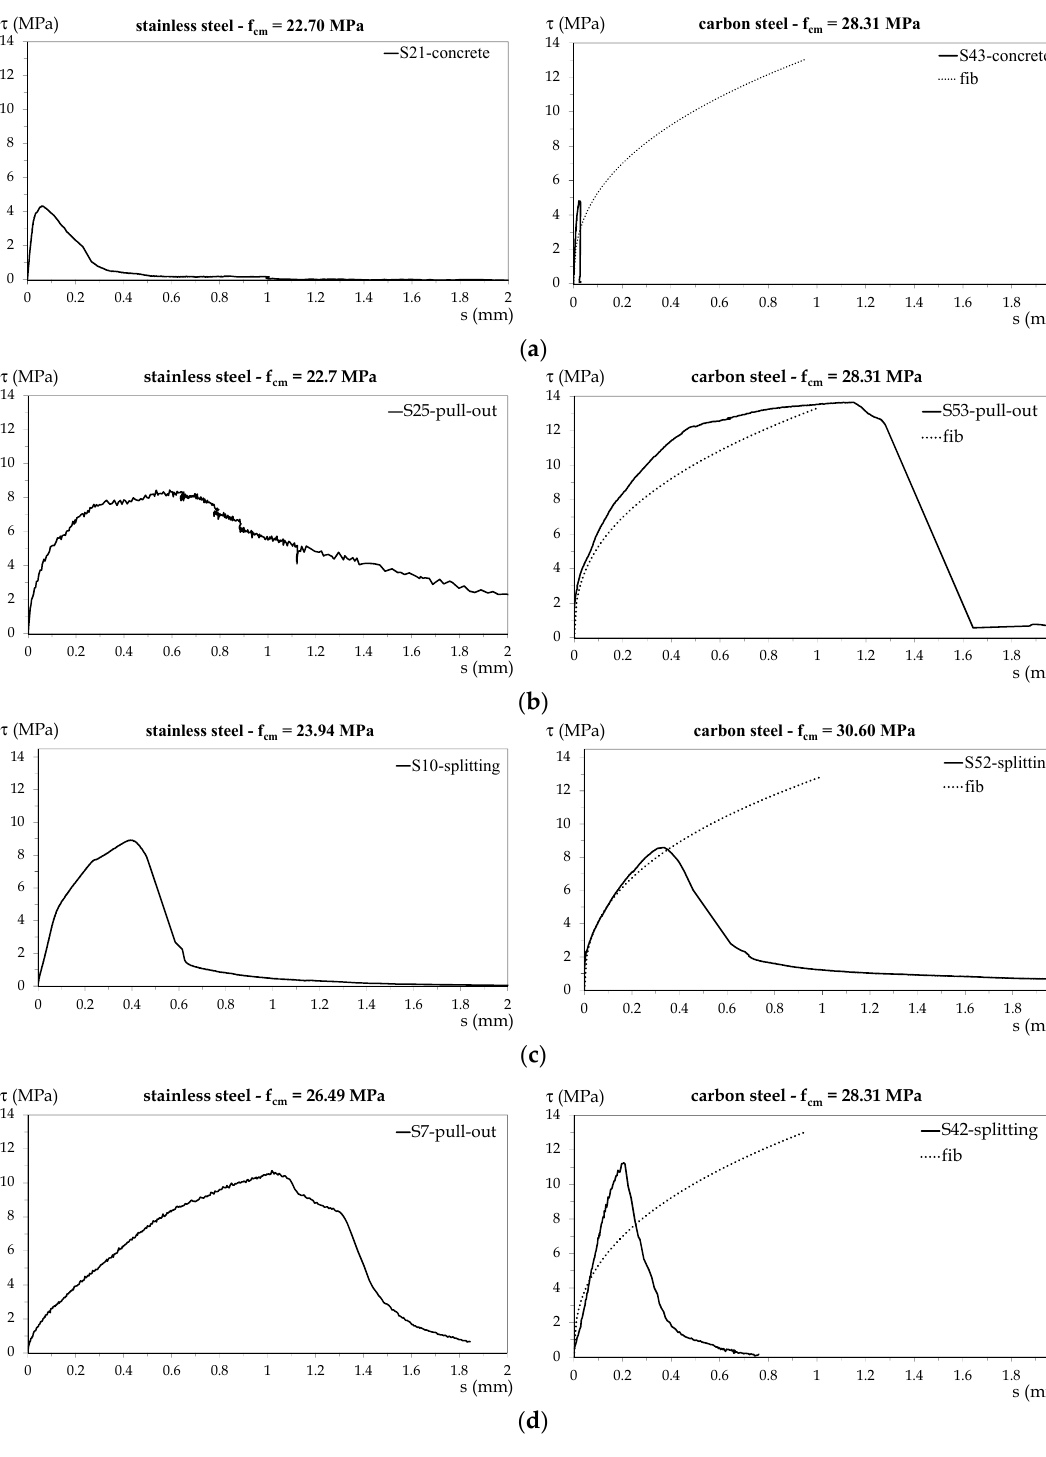
Figure 10. Bond stress–slip diagrams for specimens subjected to different failure types: ( a ) tensile concrete failure for S21 and S43; ( b ) pull-out failure for S25 and S53; ( c ) splitting failure for S10 and S52; ( d ) pull-out failure for S7 and splitting failure for S42.